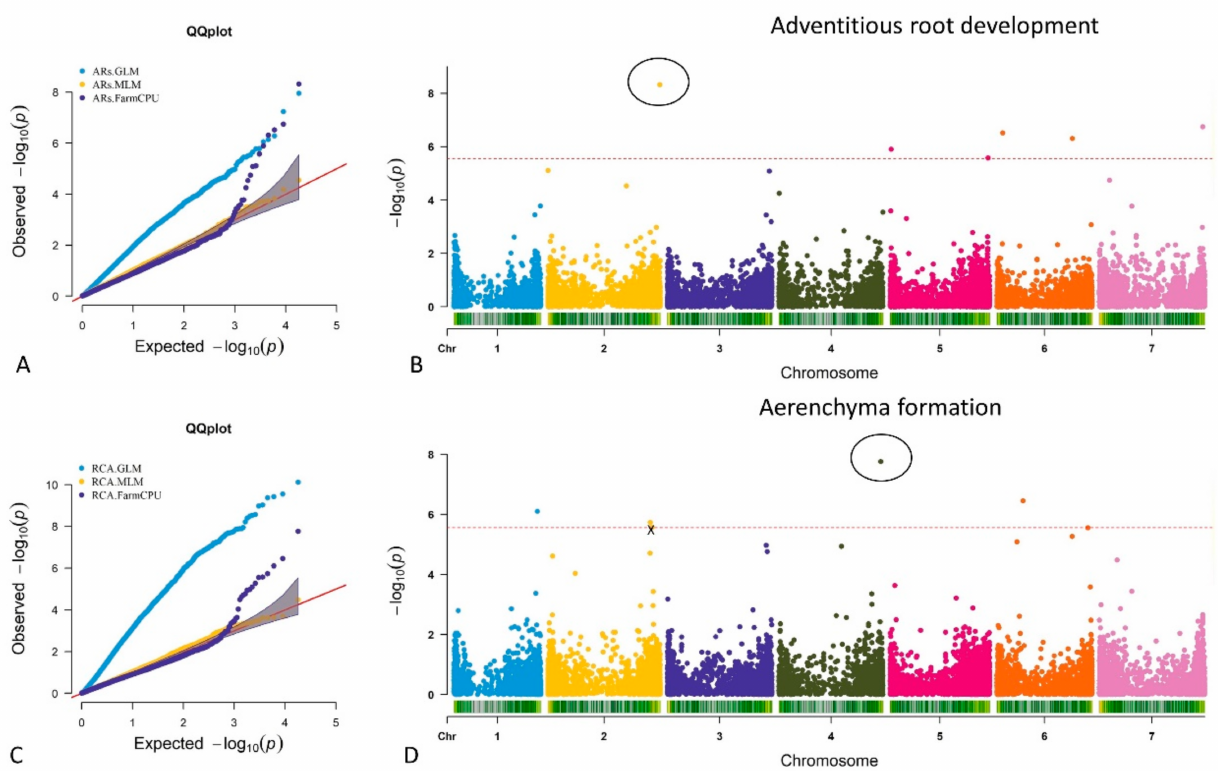
Figure 3. The quantile–quantile (QQ) plots from the models (GLM, MLM, and FarmCPU) are in ( A , C ); The FarmCPU model highlighted six potentially significant marker trait associations (MTA) for adventitious root formation from average scores of all the experiments ( B ); Five significant MTA were identified for root cortical aerenchyma (RCA) formation in adventitious roots ( D ). The highest − log 10 ( p ) MTA for adventitious root and aerenchyma formation were approximately 9 and 8 on chromosome 2H and 4H, respectively (( B ) (circle); ( D ) (circle)). Two MTA on 2H were located at similar positions (cross mark), thus counted as one MTA ( D ).